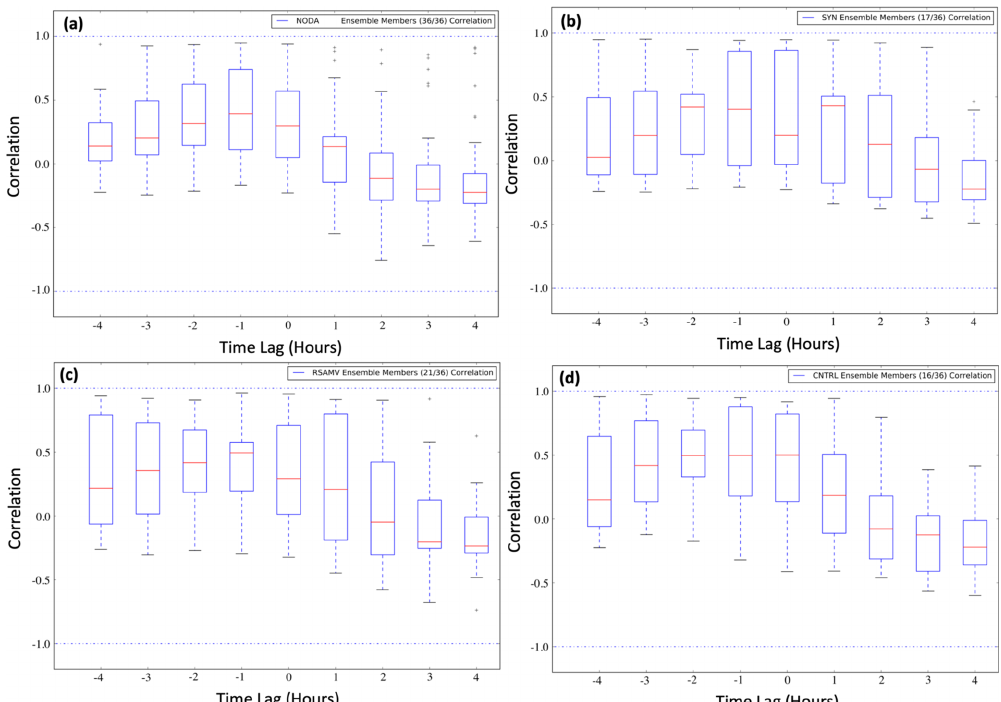
Figure 14. Whisker plots depicting the lagged correlation values between the observations and the ensemble members for the different experiments (a) NODA, (b) SYN, (c) RSAMV and (d) CNTRL. The correlation is calculated taking into account that the V-shaped signature corresponding to the observations is shifted 4h to the left and 4h to the